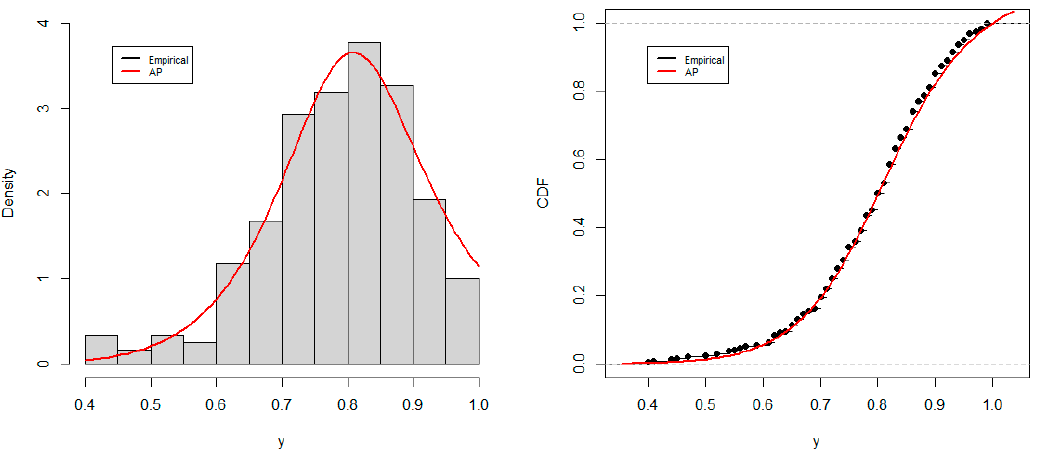
Figure 8. Histogram and estimated PDF ( left ), and empirical CDF and estimated CDF ( right ). Figure 9 displays the probability-probability (P-P) plots of the fitted distributions. This figure suggests that the AP distribution provides a good fit to the data as its expected and observed probabilities cluster along the diagonal line.